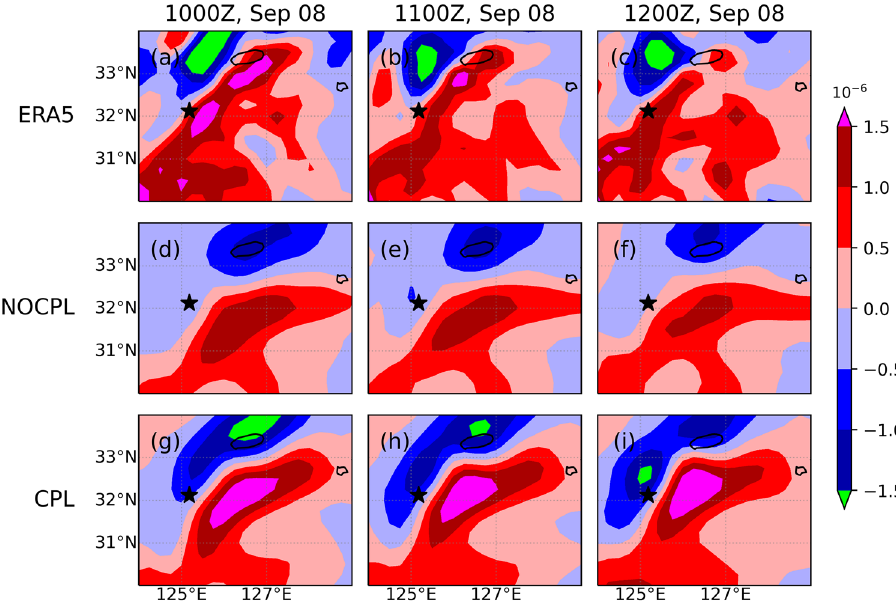
Figure 8. Same as Fig. 6 but for moisture convergence (10 –6 /s; shaded). The shaded regions indicate moisture convergence (positive) and moisture divergence (negative), respectively.